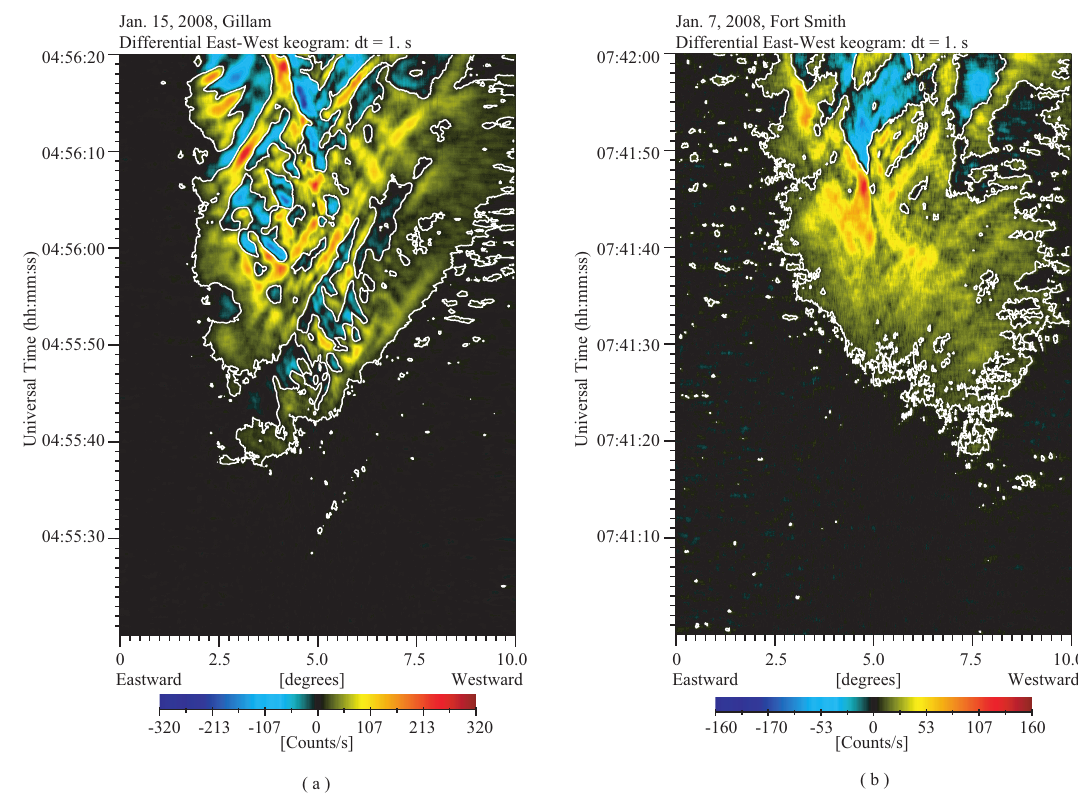
Fig. 4. East-west cross section of time-differential auroral intensity dI/dt [counts/s] at geographic latitudes of (a) 56.8 ◦ N ± 0.2 ◦ for event 1 and (b) 59.6 ◦ N ± 0.1 ◦ for event 2. These latitudes are those where the brightenings started. Differential counts are integrated between two dashed lines shown in Figs. 2b and 3b. The vertical axis is time increasing upward. The horizontal axis is distance [degrees] along the above geographic latitudes. The white contour correspond to dI/dt= (a) 10 and (b)